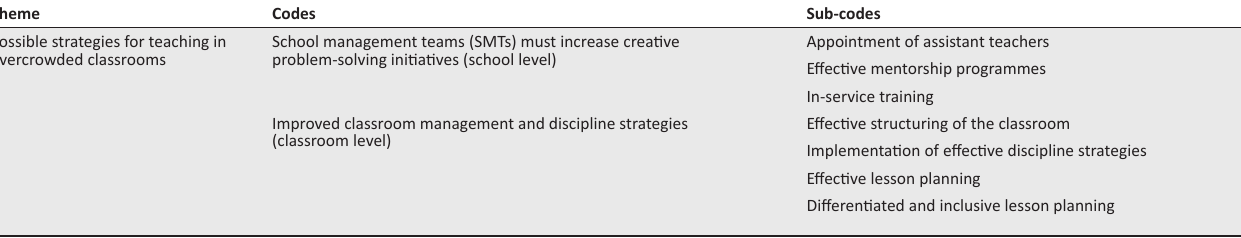
TABLE 2: Theme 2: Possible strategies for teaching in overcrowded classrooms.